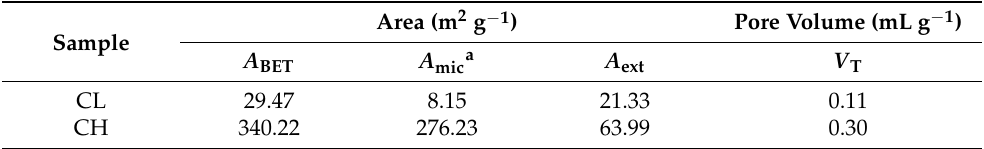
Table 2. Textural parameters of raw zeolite samples obtained from N 2 adsorption at − 195.8 ◦ C.